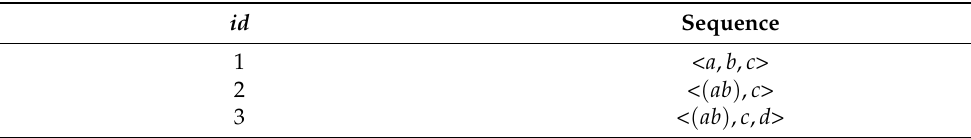
Table 1. An example of sequence